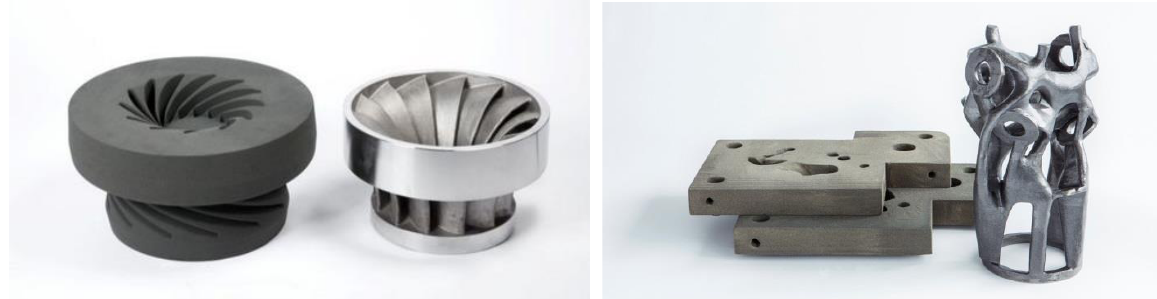
Fig. 6a) Example of metal casting (right) by a 3D-printed sand mould (left). Derived from www.voxeljet.com.